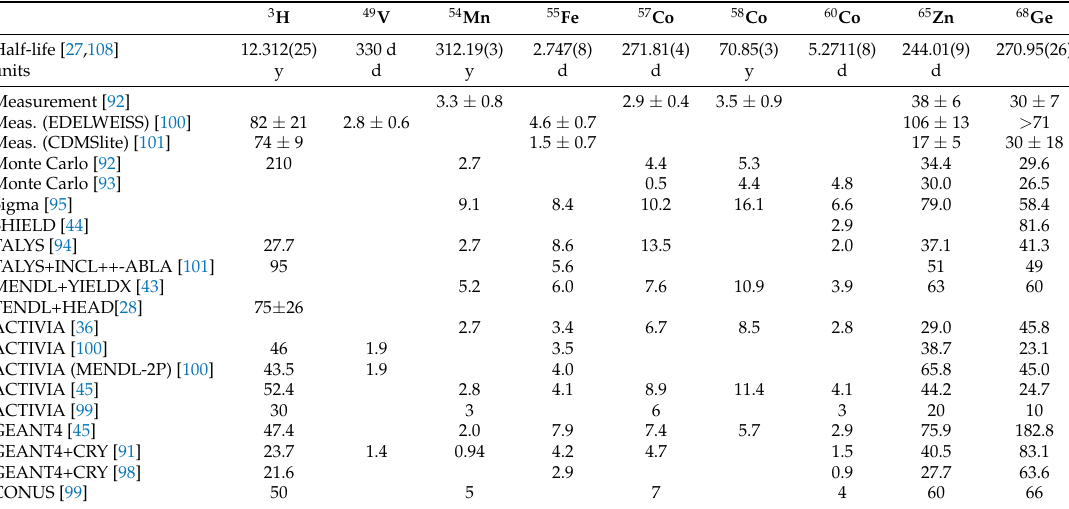
Table 2. Rates of production of long-lived radioisotopes induced in natural germanium at sea level. Measurements from Refs. [92,100] and different calculations are presented (see text). All numbers are expressed in